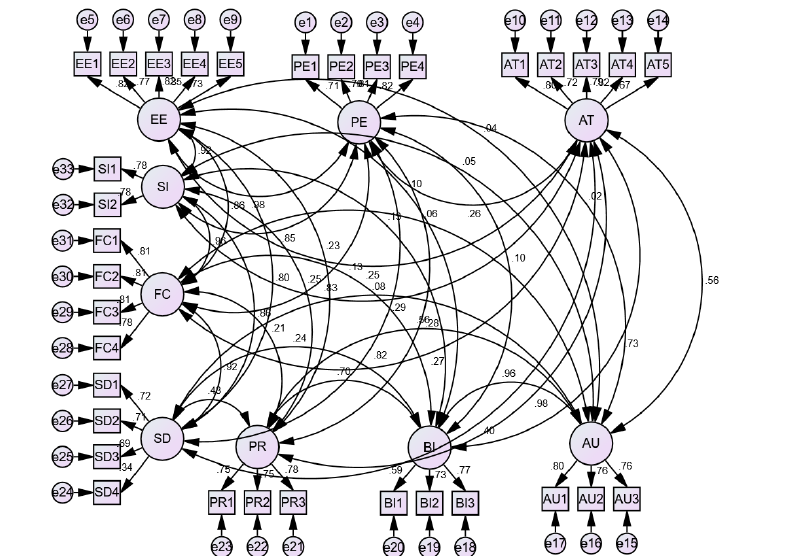
Figure 2. Confirmatory factor